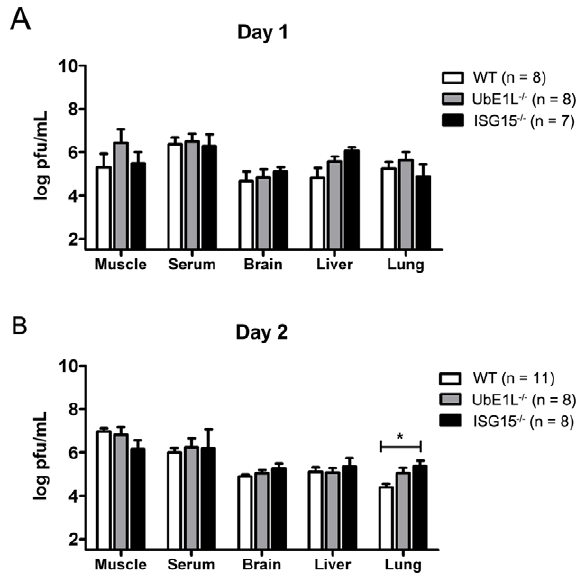
Figure 7. ISG15 2 / 2 and UbE1L 2 / 2 mice display similar viral loads to WT mice. Nine day old WT, UbE1L 2 / 2 and ISG15 2 / 2 mice were injected with 2 6 10 5 PFU CHIKV s.c. Tissue and sera were collected on days 1 ( A ) and 2 ( B ) post-infection and viral titers were determined by plaque assay; vertical bars represent standard error of the mean. A three way comparison of the three genotypes performed using a Kruskal-Wallis analysis was not significant except for the lung on day 2 post infection (*, where p , 0.05).